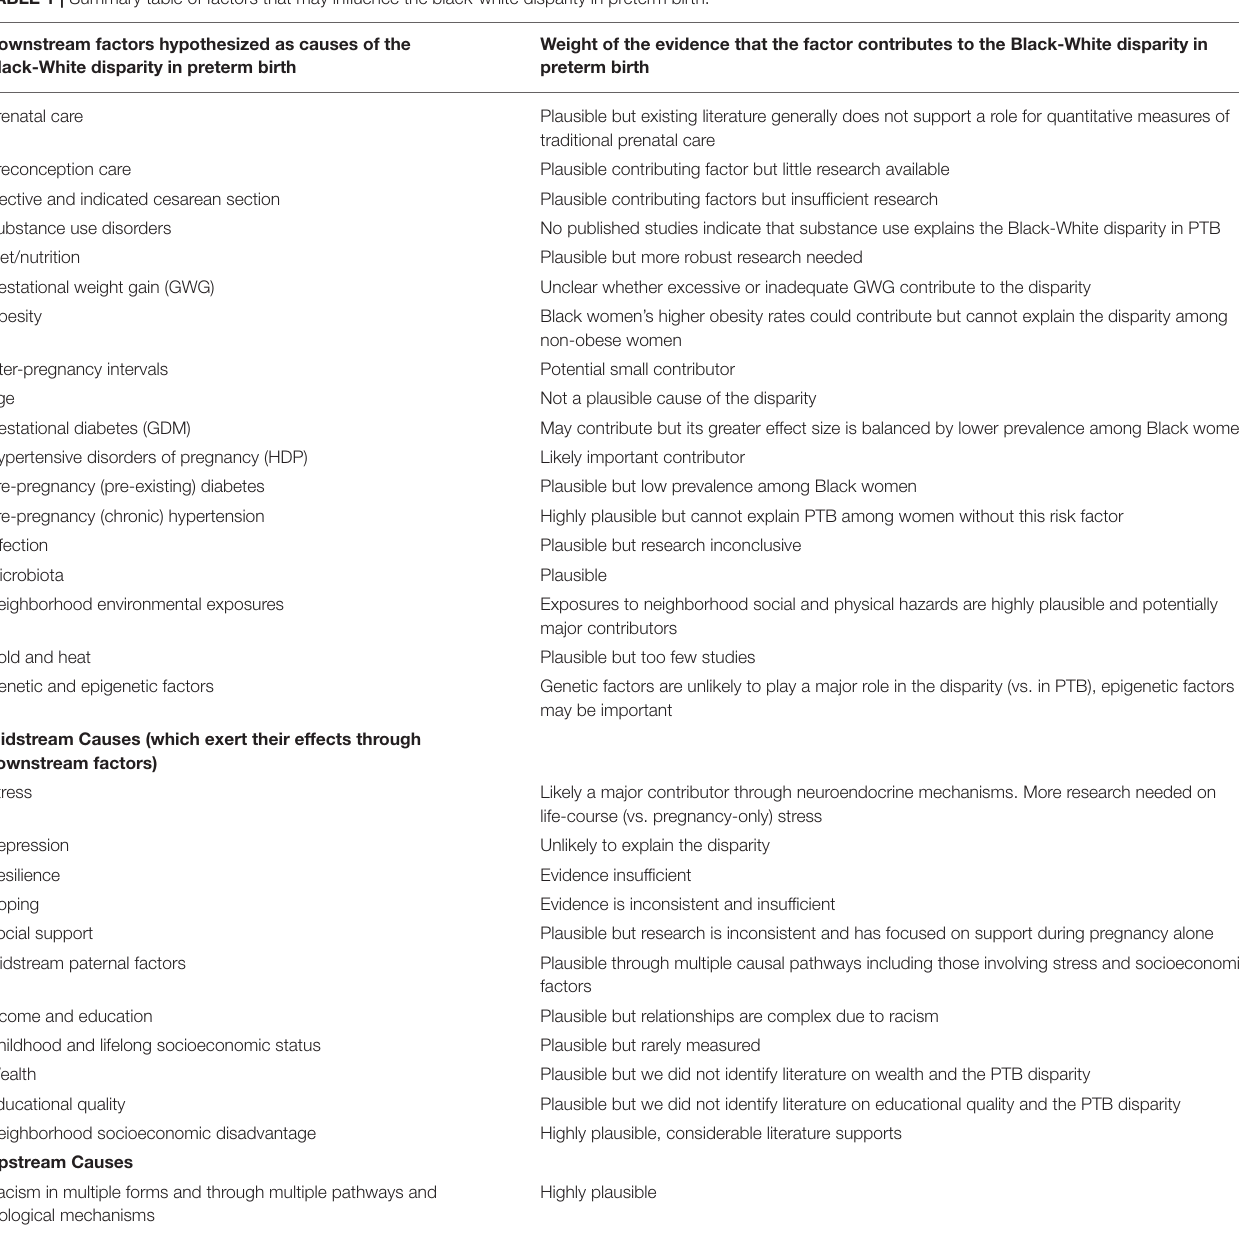
TABLE 1 | Summary table of factors that may influence the black-white disparity in preterm birth. Downstream factors hypothesized as causes of the Black-White disparity in preterm